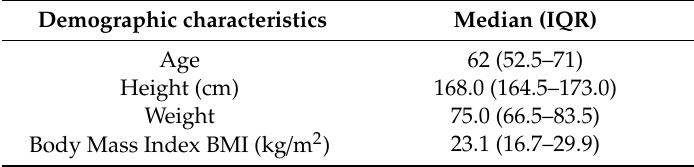
Table 1. Distribution of sample according to demographic characteristic ( n =